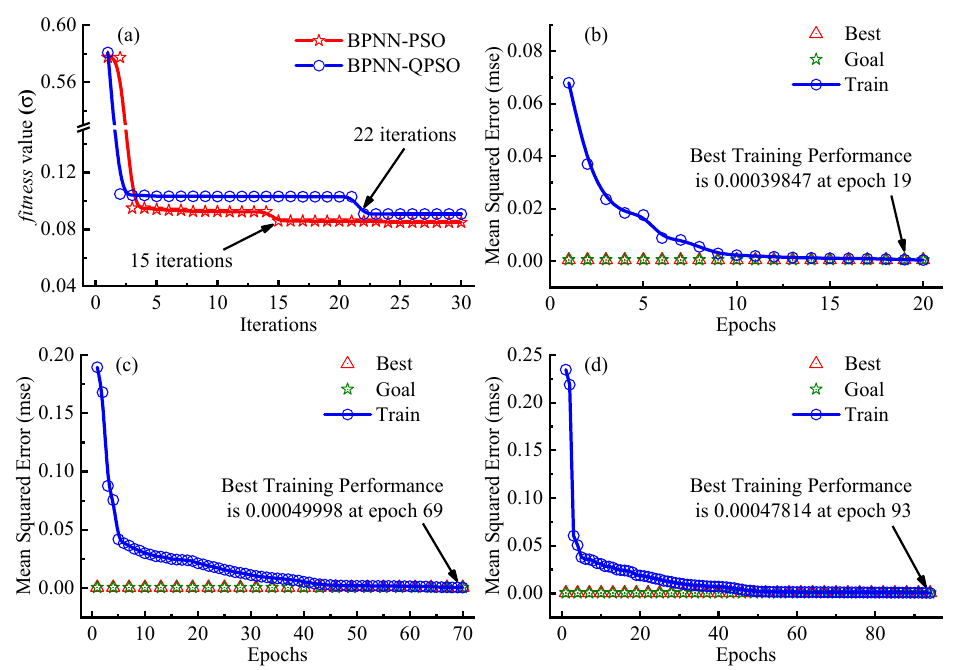
Figure 8. Training performance of the network model: ( a ) fitness iteration of standard error; ( b ) BPNN training process; ( c ) BPNN-PSO training process; ( d ) BPNN-QPSO training process.